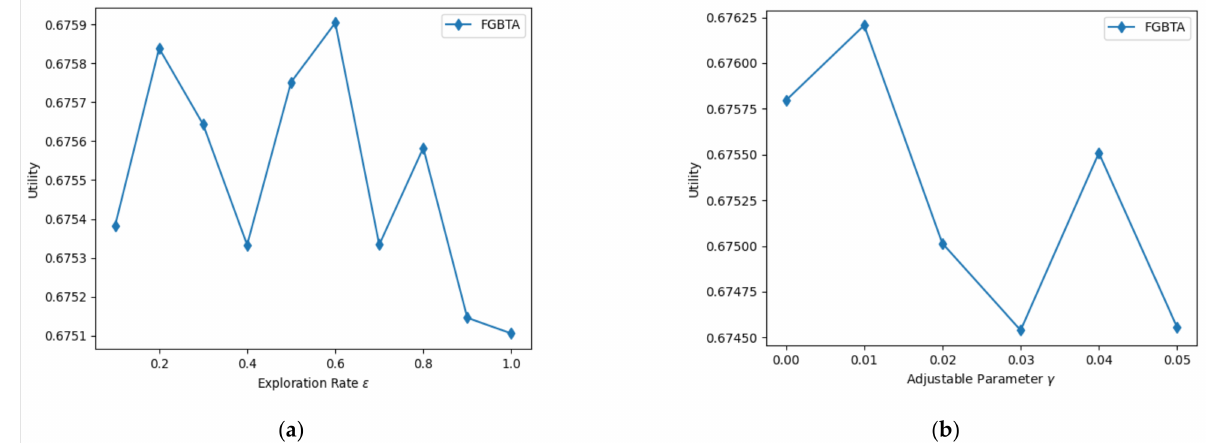
Figure 7. ( a ) Utility of varying exploration rate (cid:101) ; ( b ) utility of varying adjustable parameter γ .